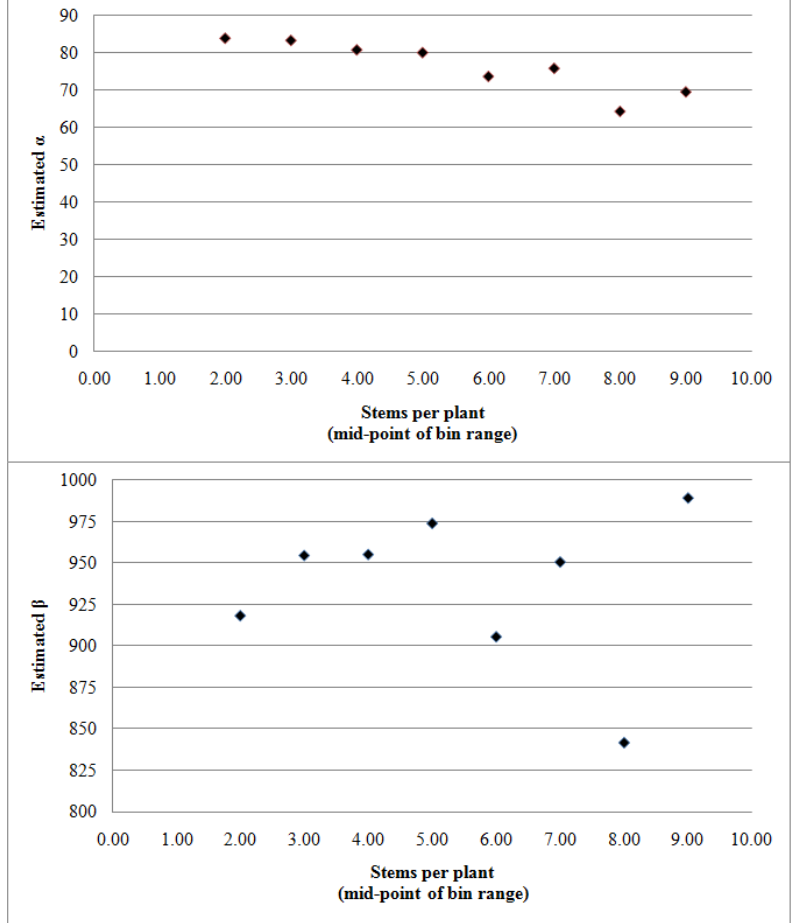
Figure 1. Logistic model α and β parameter estimates plotted against the mid-point of the stem number per plant data bin ranges 0–3, 2–4, 3–5, 4–6, 5–7, 6–8, 7–9, and 8–10 to visually assess relationship between estimated parameters and measured plant variables.